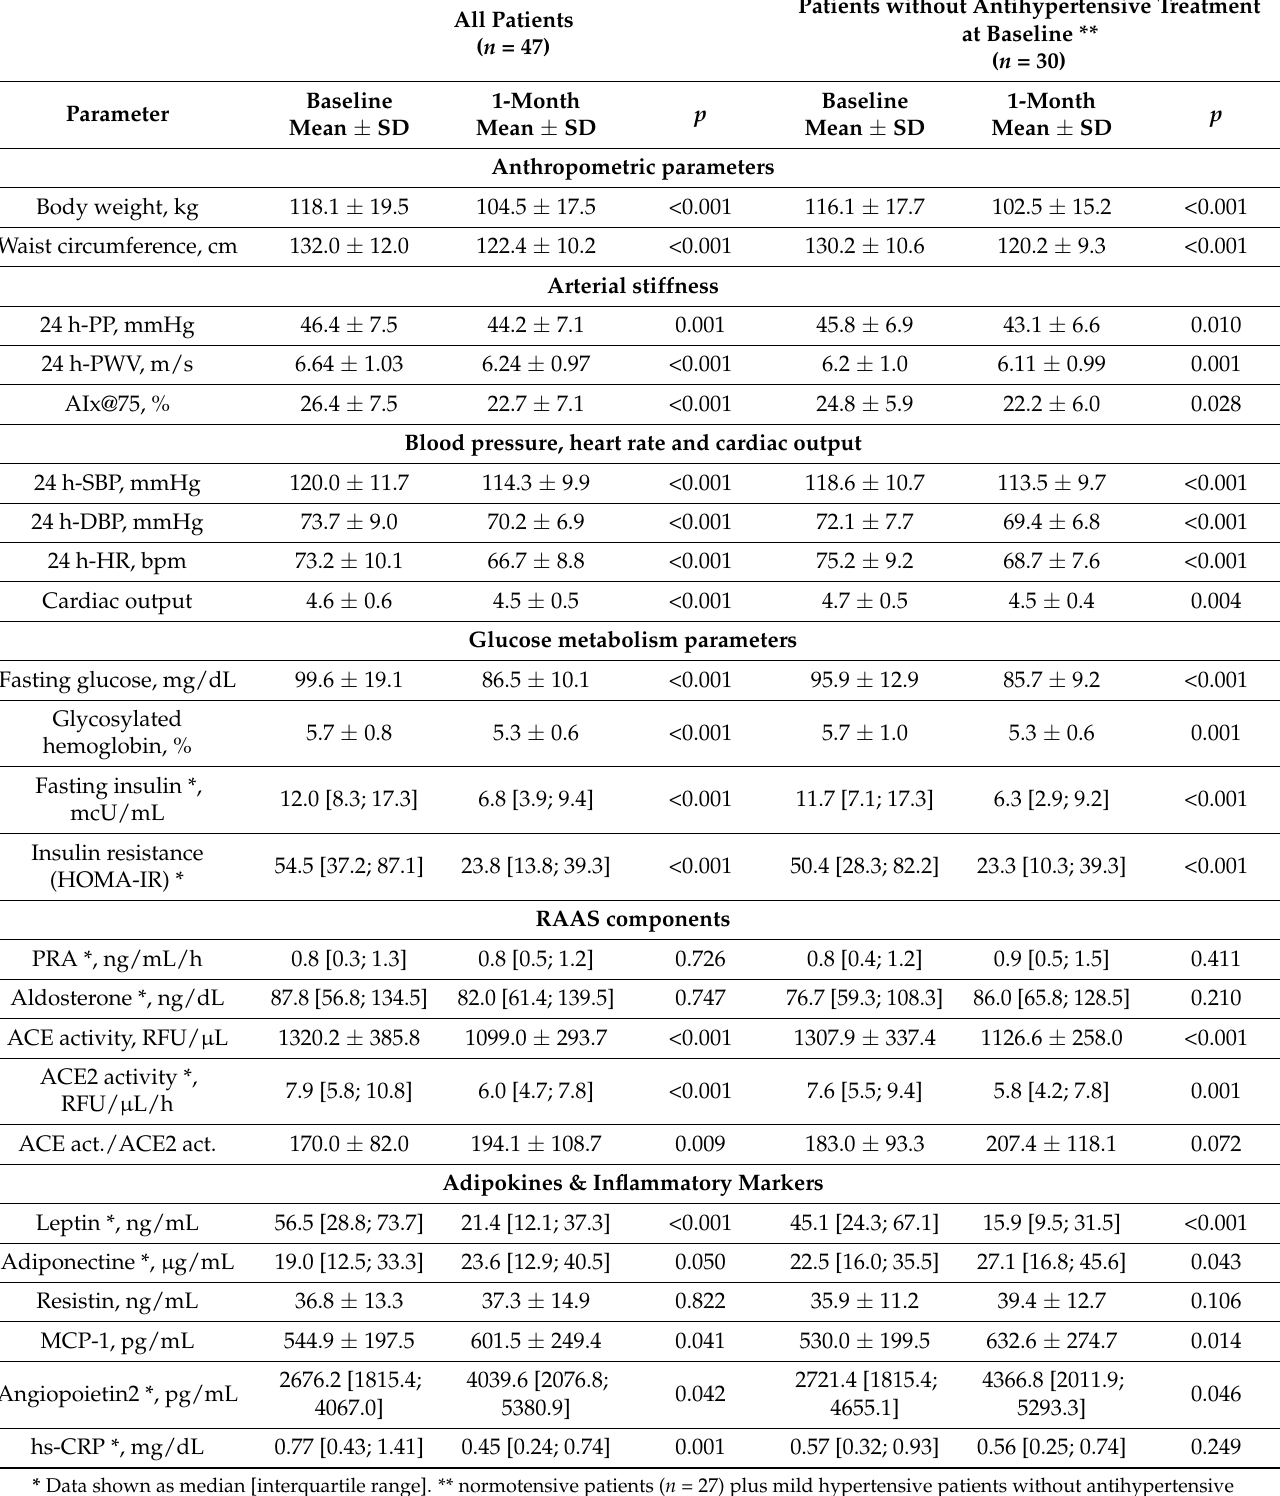
Table 2. Changes 1-month after bariatric